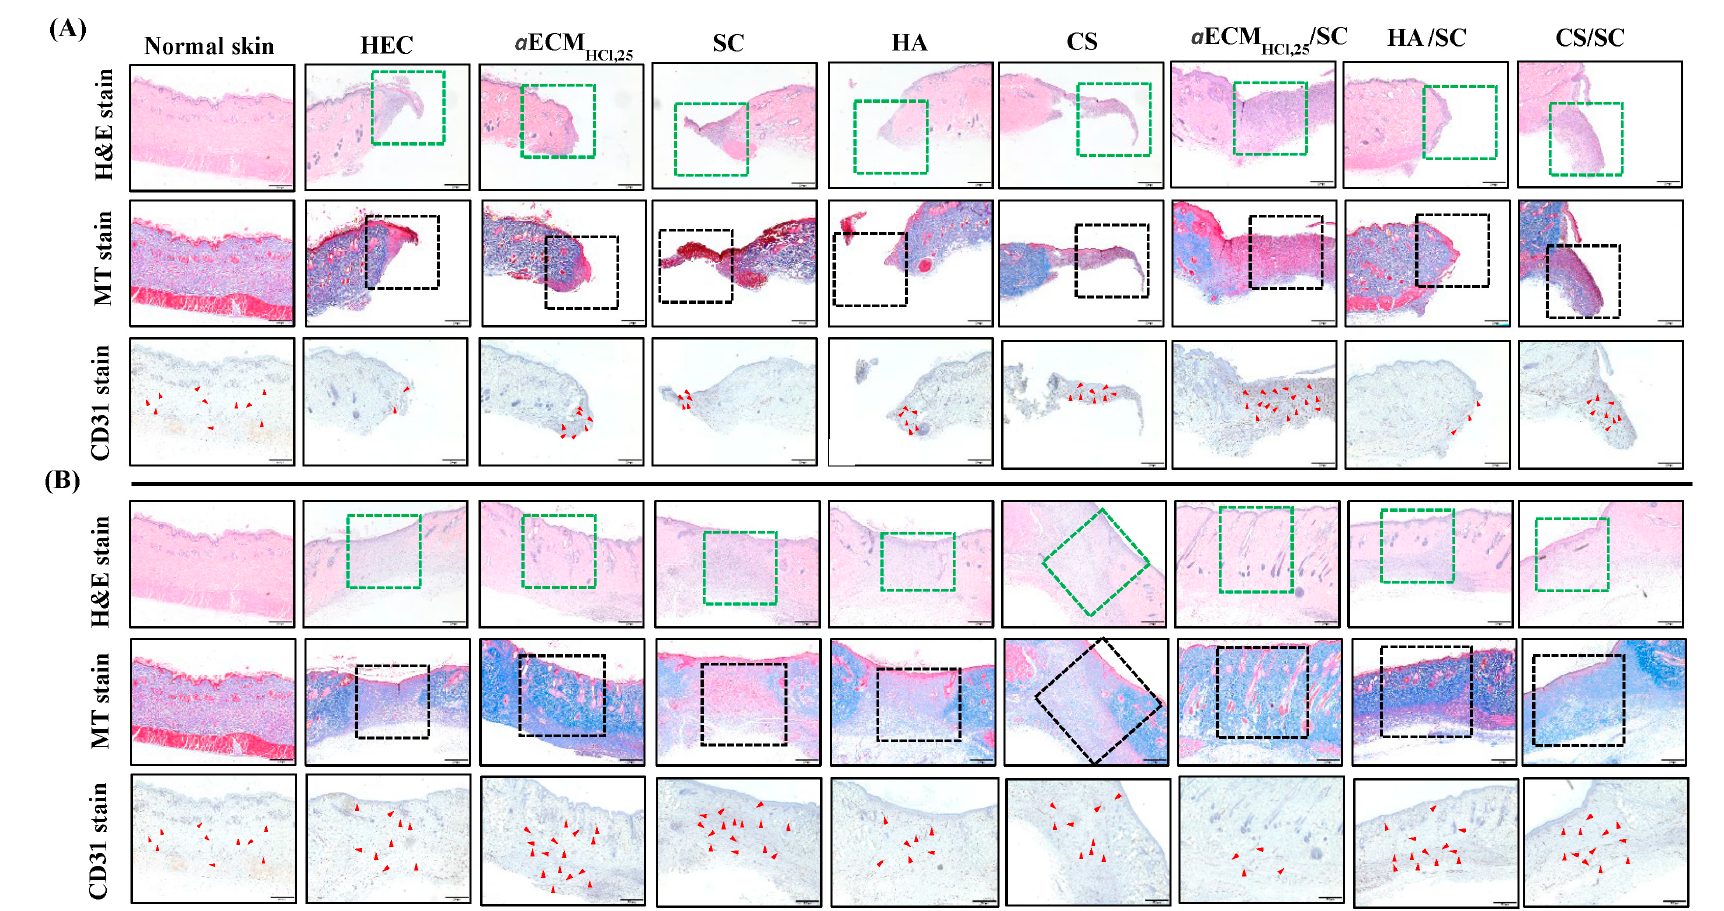
Figure 7. Histologic analysis of normal skin and wounds treated with different dressings. Top to bottom displays hematoxylin and eosin (H&E), Masson’s trichrome (MT) and cluster of differentiation 31 (CD31) immunohistochemical staining. ( A ) Day 8, ( B ) day 14. Scale bar: 500 µm at 4×.